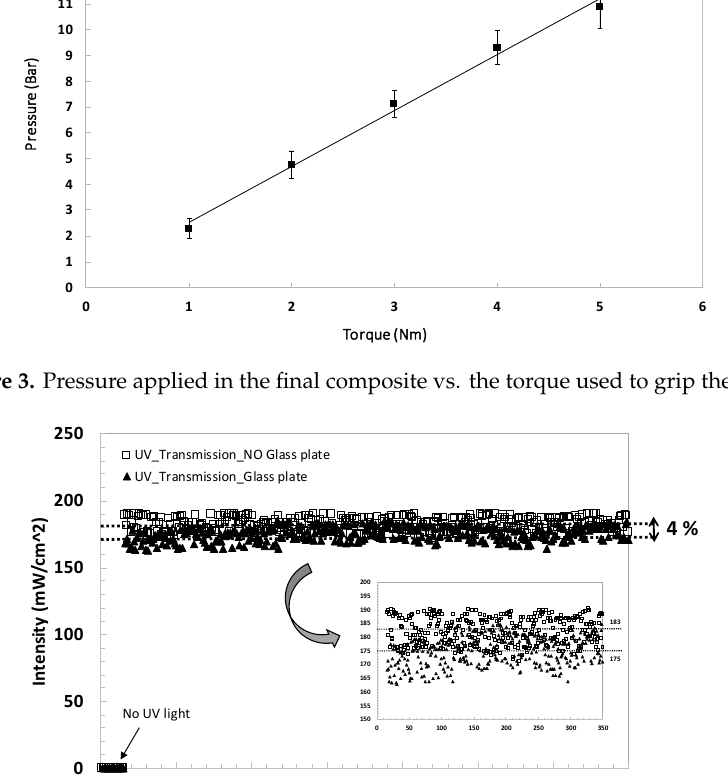
Figure 3. Pressure applied in the final composite vs. the torque used to grip the tool.